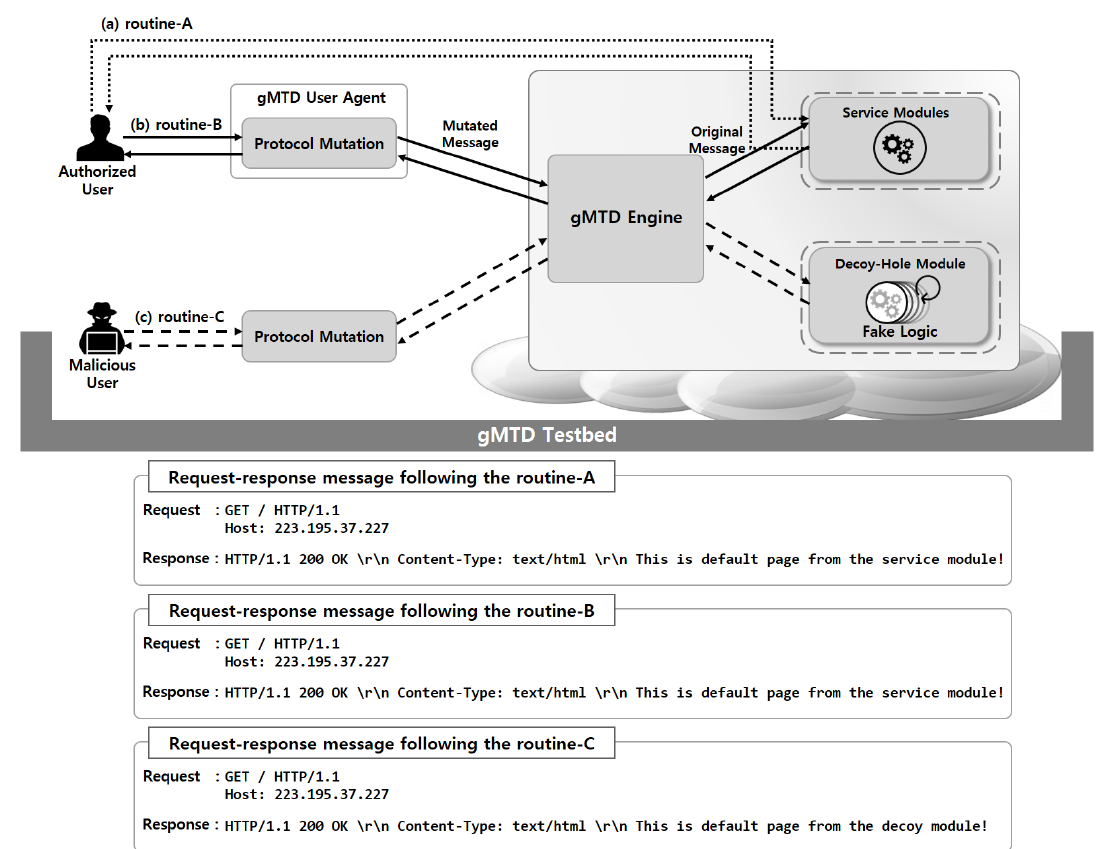
Figure 7. gMTD testbed for verification of the implementation correctness: ( a ) routine-A is a non- gMTD routine where a user directly accesses the service module without using gMTD ; ( b ) routine-B is a gMTD routine in which an authorized user accesses to the service module on the basis of gMTD ; ( c )